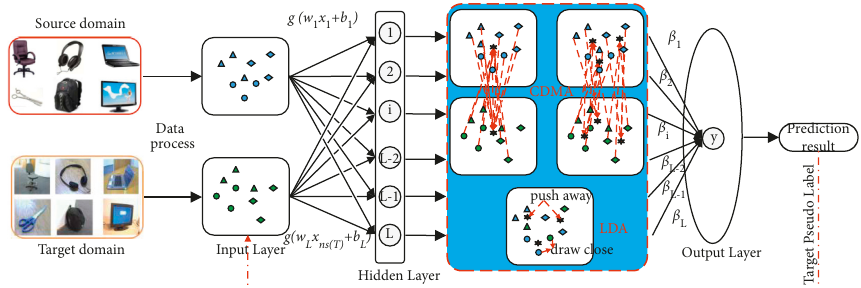
Figure 1: An illustration of DELM-CDMA. (1) Cross-domain mean approximation (CDMA) is adopted to reduce the domain shift. (2) Linear discriminant analysis (LDA) is added into object function to enhance the discrimination ability of DELM-CDMA. (3) The objective function is solved